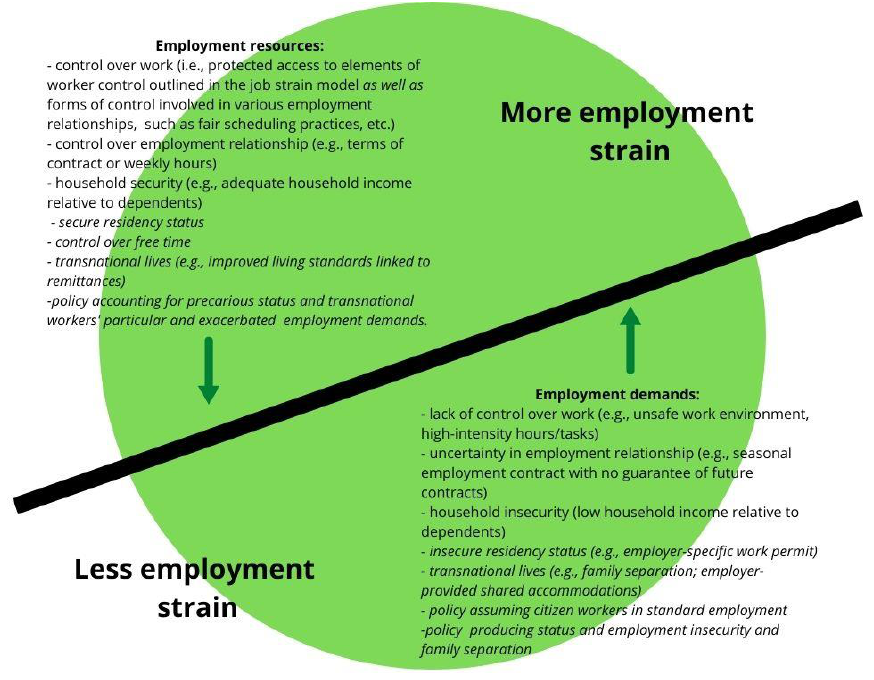
Figure 2. Transnational employment strain among workers both with various residency statuses and engaged in diverse employment relationships.